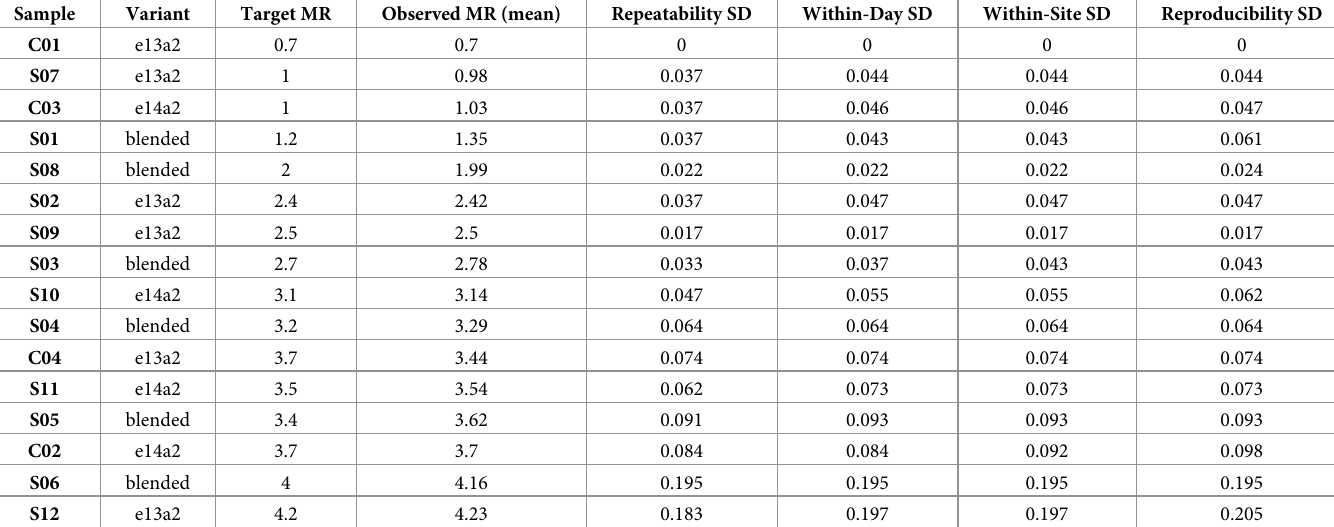
Table 4. Multi-site clinical reproducibility (N =